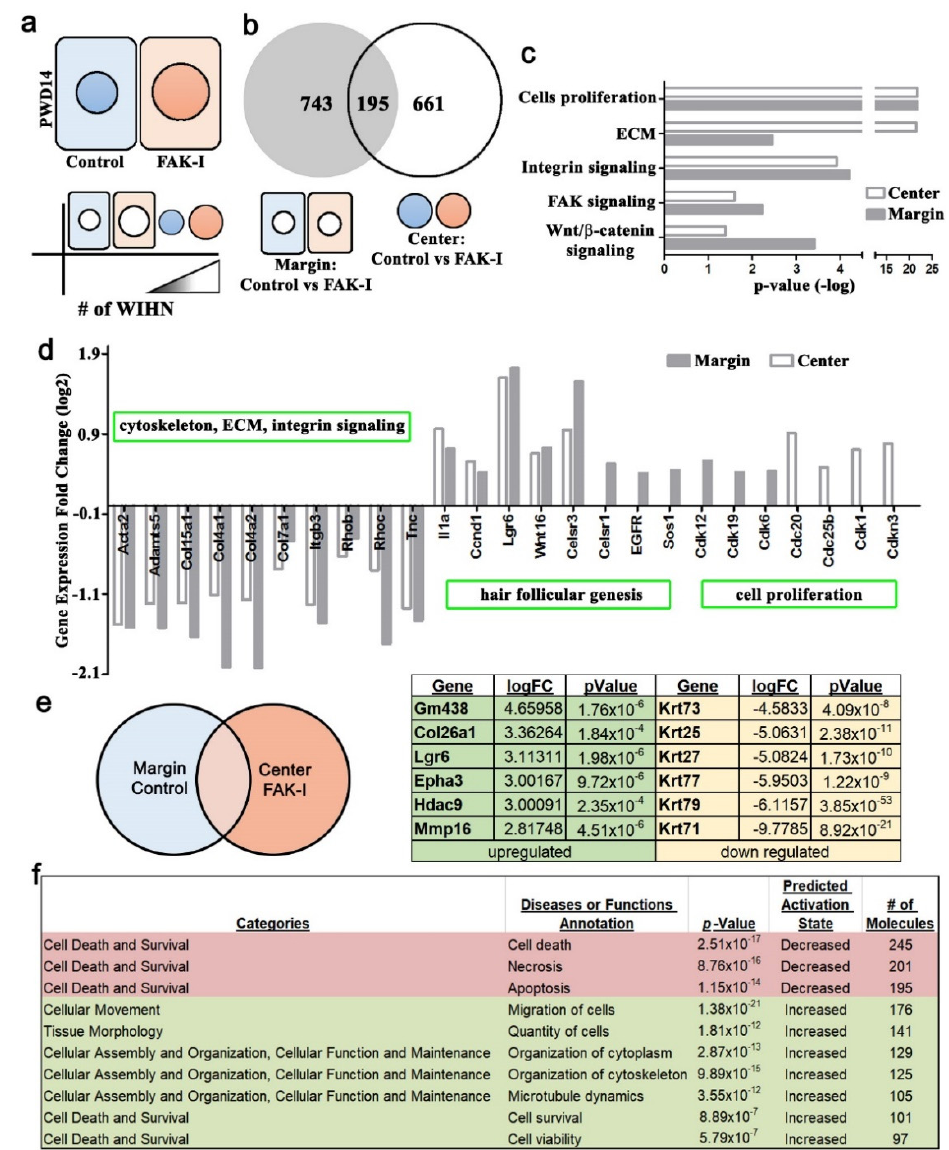
Figure 4. RNA-seq and GSEA identified genes and molecular pathways altered by FAK inhibition during wound-induced hair follicle neogenesis. ( a ) RNA-seq experiment diagram depicting PWD 14 wound epithelium centers and margins treated with or without 1 μ M FAK inhibitor. ( b ) Venn diagram of differentially expressed genes; control versus treated center epithelium ( n = 856) and control versus treated margin epithelium ( n = 938). ( c ) Gene ontology analysis of control versus treated wound center or margin epithelia. ( d ) Differential gene expression analysis of control versus treated wound center or margin epithelia. ( e ) Venn diagram and table showing differential gene expression analysis of FAK-I treated center versus control margin wound epithelia highlighting top gene expression changes. ( f ) Gene set enrichment analysis of FAK-I treated wound center versus control margin wound epithelium showing upregulation of tissue morphology and downregulation of cell death functions.